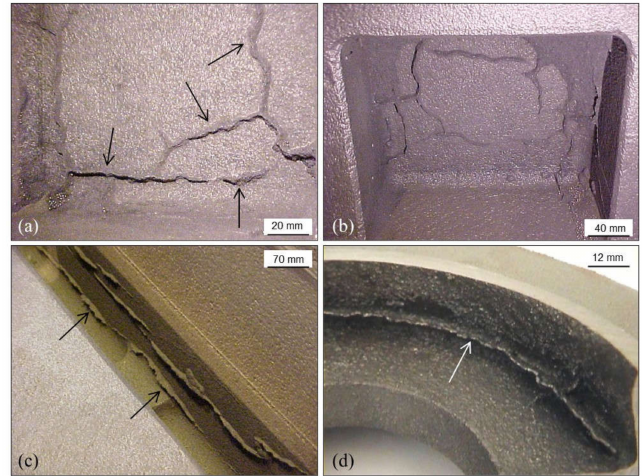
Figure 29. Veining in ( a – c ) ductile iron heavy-section castings produced with chemically bonded silica sand molds; ( d ) an internal area of a grey iron casting produced in a green sand mold with cores that led to the shown defect.